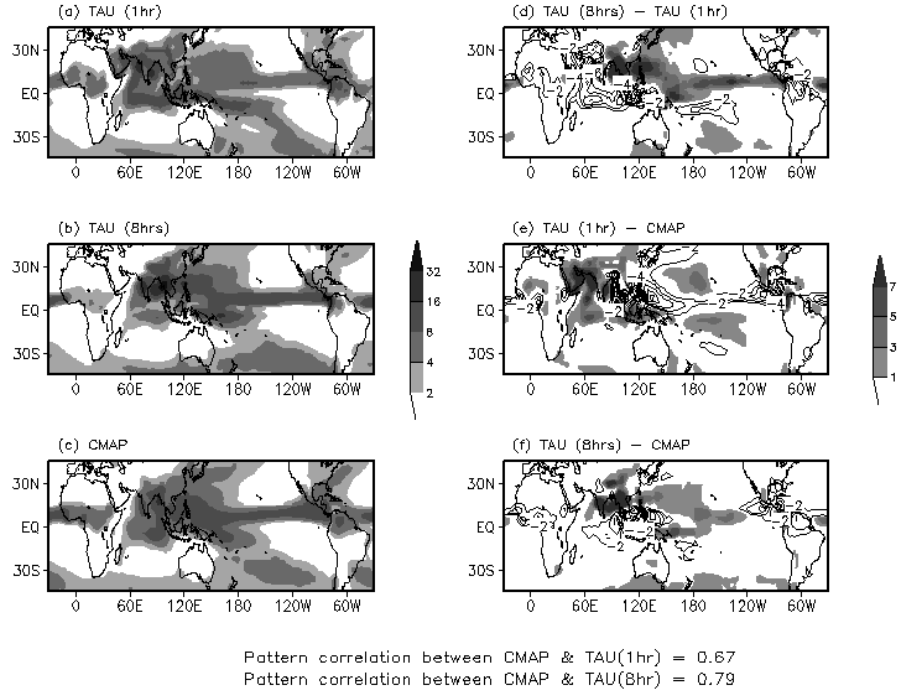
Fig. 22. Climatological mean JJA precipitation (mm/day) for (a) TAU (1h), (b) TAU (8h), (c) CMAP, (d) [TAU (8h) – TAU (1h)], (e) [TAU (1h) – CMAP], and (f) [TAU (8h) – CMAP]. The climatological mean is derived from 10 years (1979 to